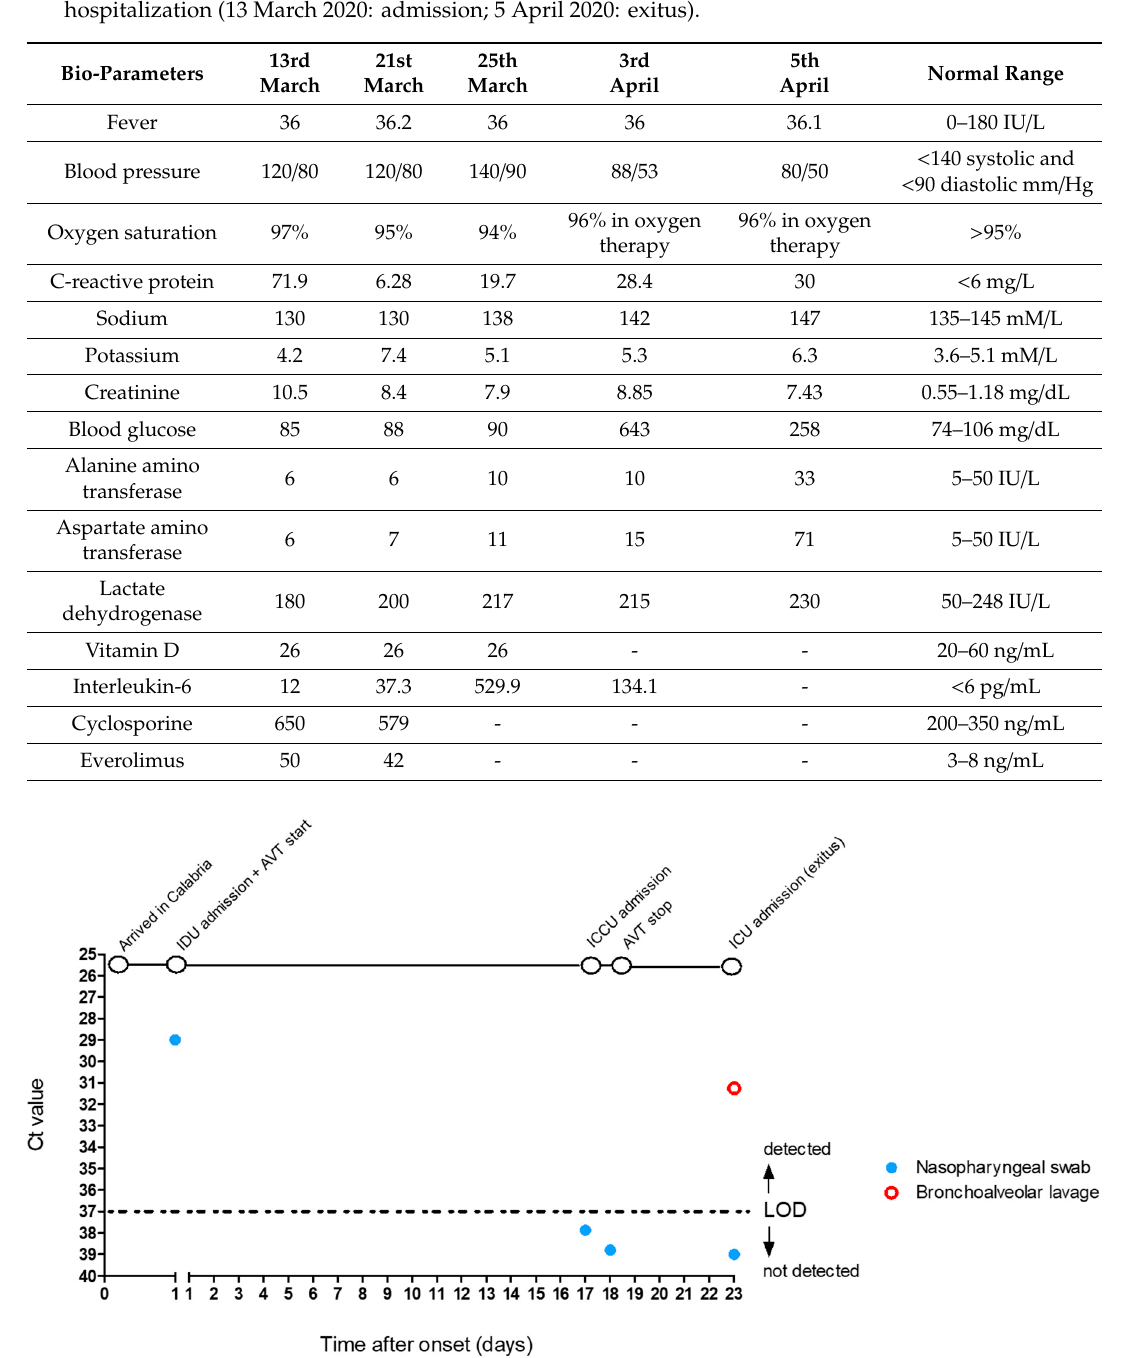
Table 1. Clinical parameters, clinical biochemistry and pharmacology profile recorded during the